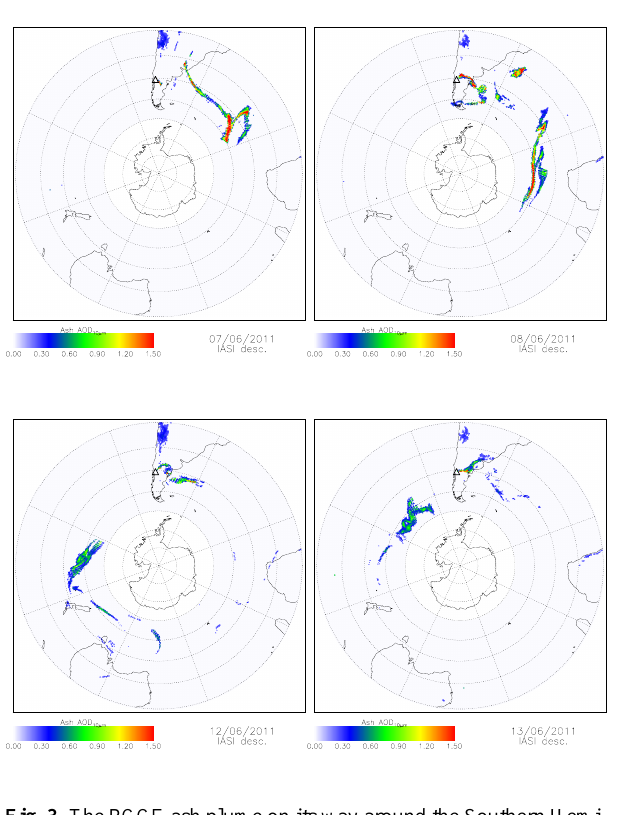
Fig. 4. Probability of ice crystals in ash plume for descending orbits of 7 and 8 June 2011 (top row) and ice cloud index for all IASI observations (bottom